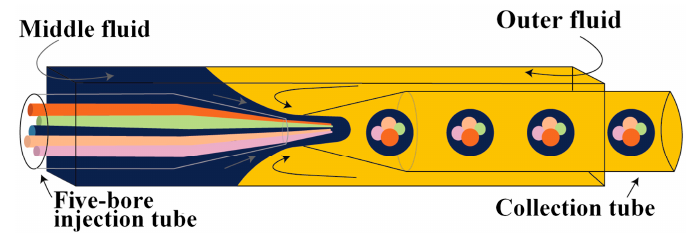
Figure 19. A glass capillary device for generation of W/O/W drops with four distinct inner oil drops. The injection tube has five bores, which allows four different oil phases indicated in different colours and one aqueous phase in the middle to be injected separately [66].